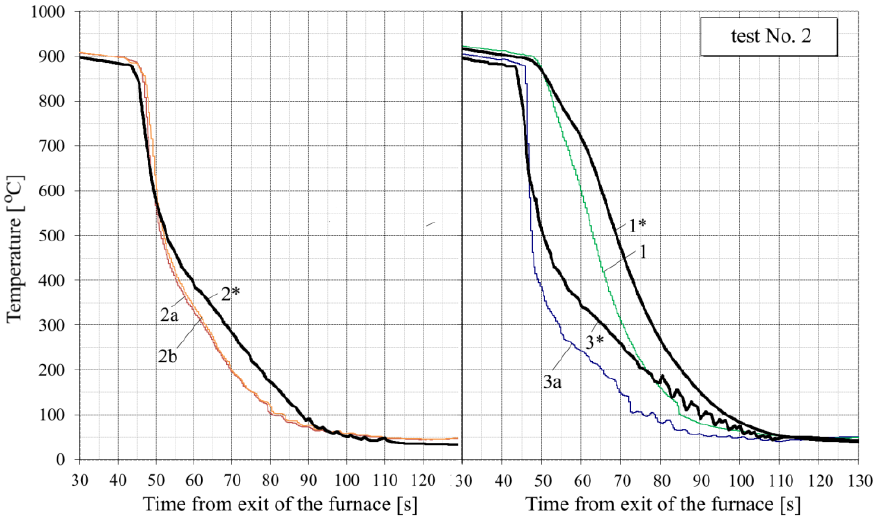
Figure A2. Graphs of cooling in test No. 2. The notations are the same as in Figure A1.